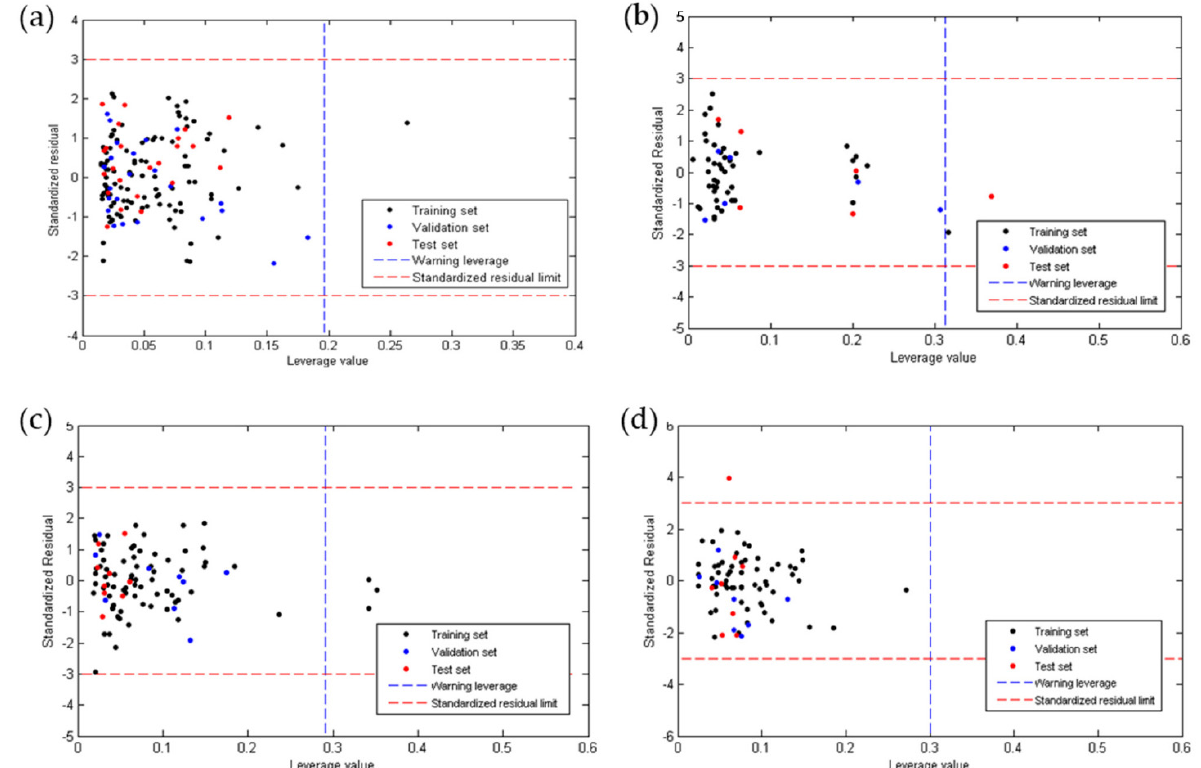
Figure 3. h lim values for ( a ) anti-chagas (Table S5); ( b ) anti- L. amazonensis (Table S10); ( c ) anti- L. in- fantum (Table S11) activity, and ( d ) toxicity (Table